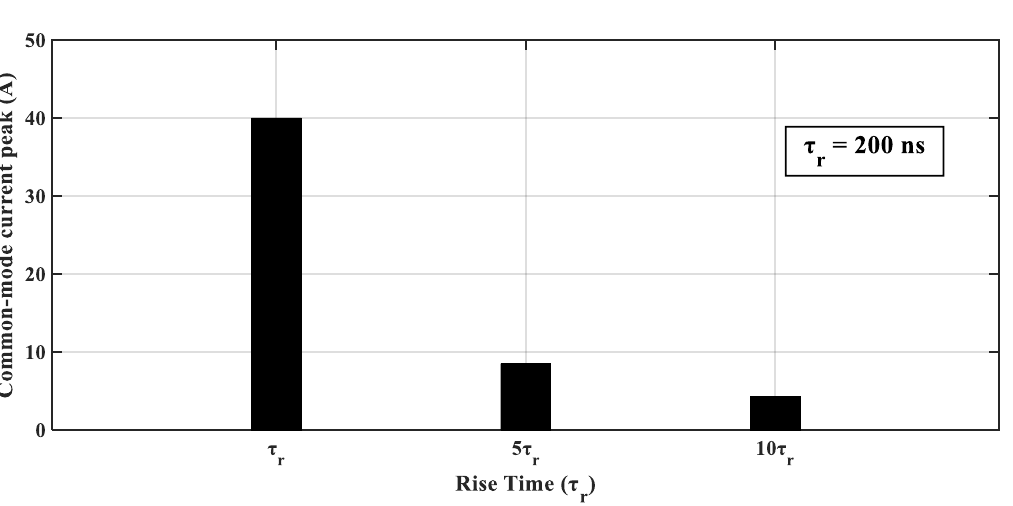
Figure 13. Relationship between the rise time of common-mode voltage and peak value of common- mode current.